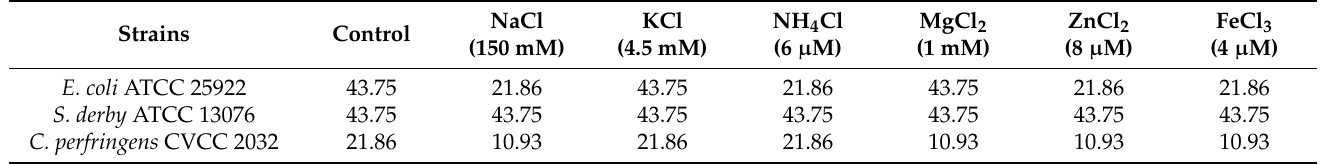
Table 3. MIC values ( µ g/mL) of BMGlv2 in the presence of salts.